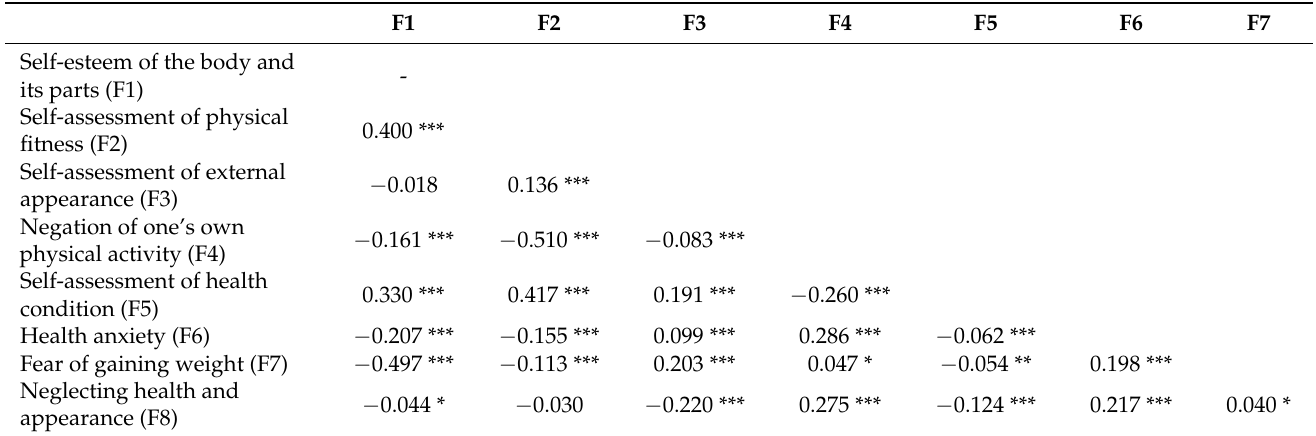
Table 5. Correlation matrix between the subscales of the MBSRQ-PL questionnaire.